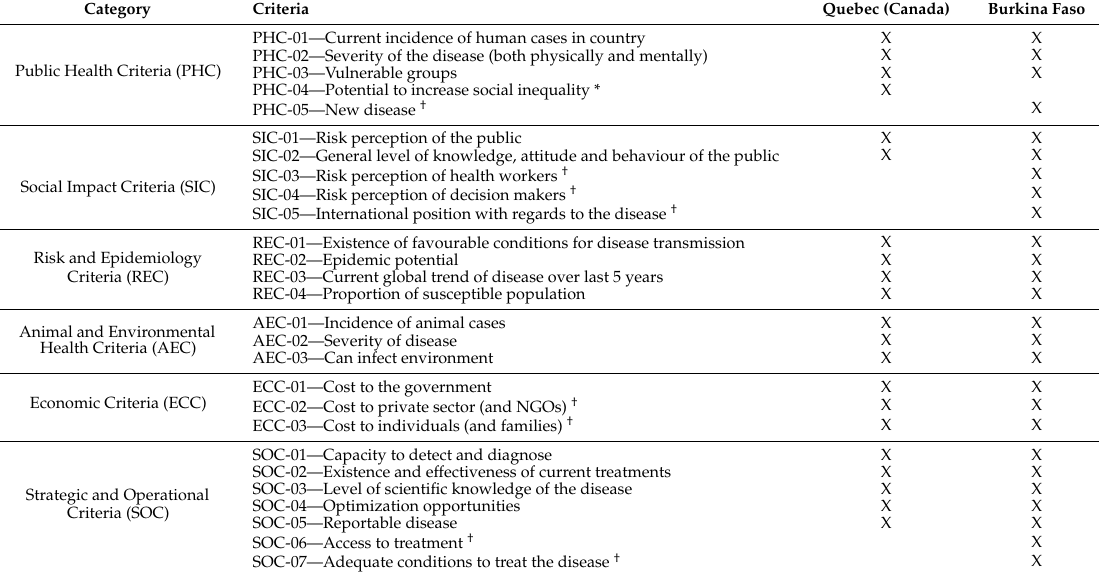
Table 1. Criteria for the prioritization of climate sensitive infectious diseases (list of criteria identified and validated by focus groups participants in Quebec (Canada) and Burkina